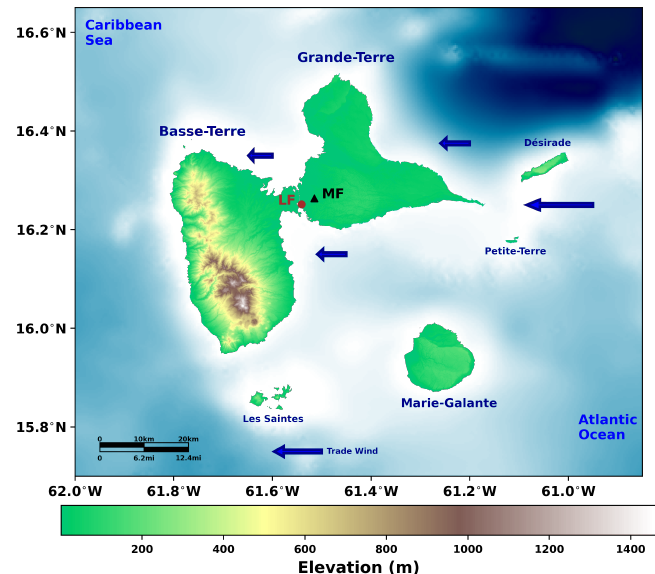
Figure 1. Map of the Guadeloupe archipelago with the locations of Météo France ( MF ) indicated by a black triangle and the biggest open landfill ( LF ) site indicated by a red circle. The arrows highlight the trade wind